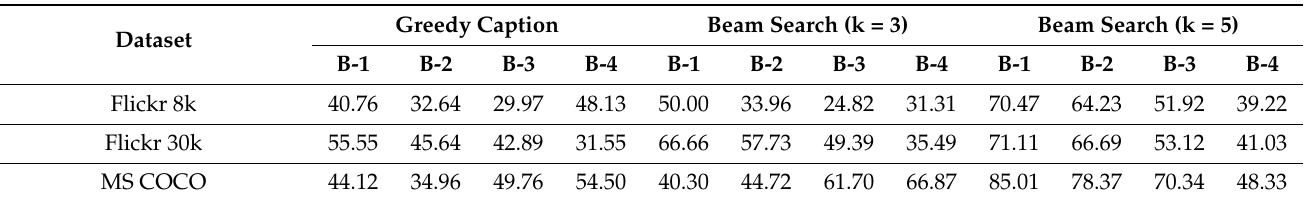
Table 3. Performance comparison in terms of bilingual evaluation understudy scores on Flickr 8k, Flickr 30k and MS COCO datasets with greedy search, beam search with beam width three and beam search with beam width five using the dual-modal transformer model.